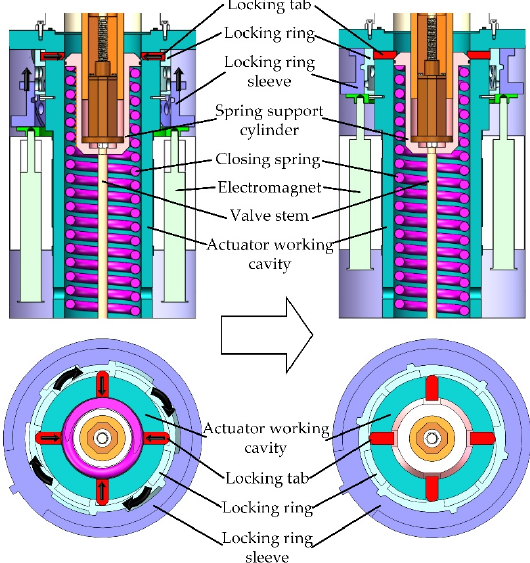
Figure 2. The locking and holding process of the low-power holding mechanism.